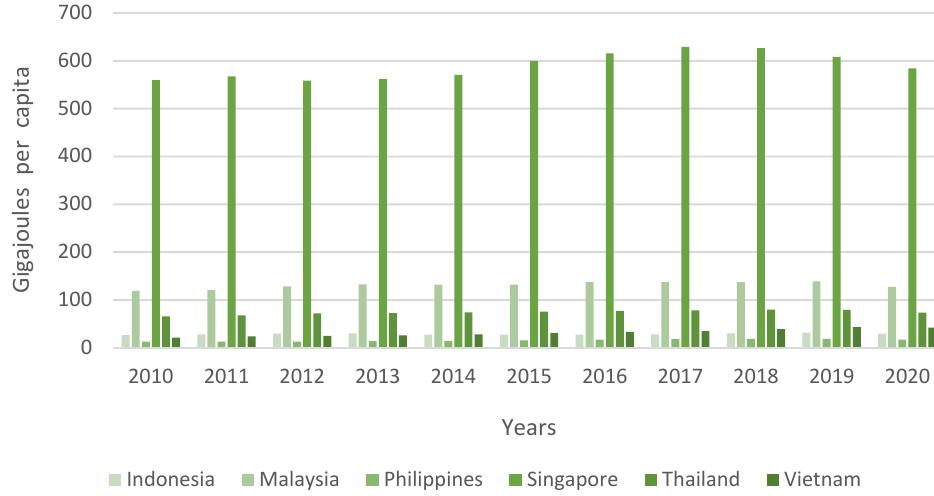
Figure 2. Primary Energy Consumption Per Capita in the Region. Note: primary energy comprises commercially traded fuels, including modern renewables used to generate electricity. Source: Statistical Review of World Energy 2021|70th edition.